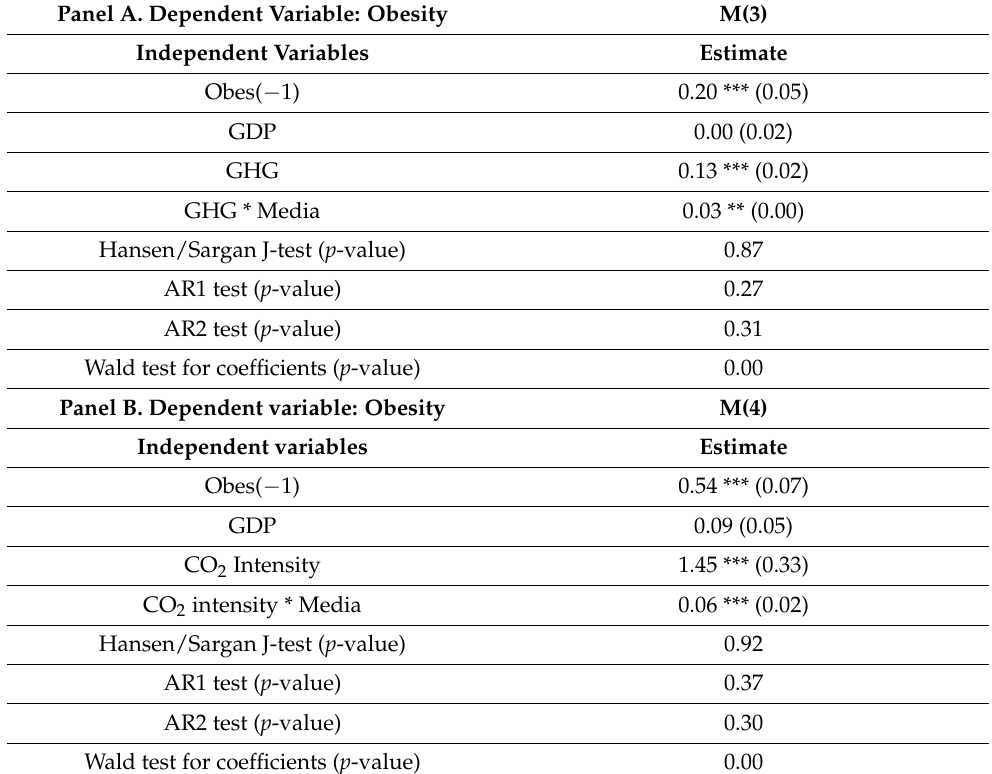
Table 6. Estimation results: Alternative pollution factor and the addition of the interaction actor. Panel A. Dependent Variable: